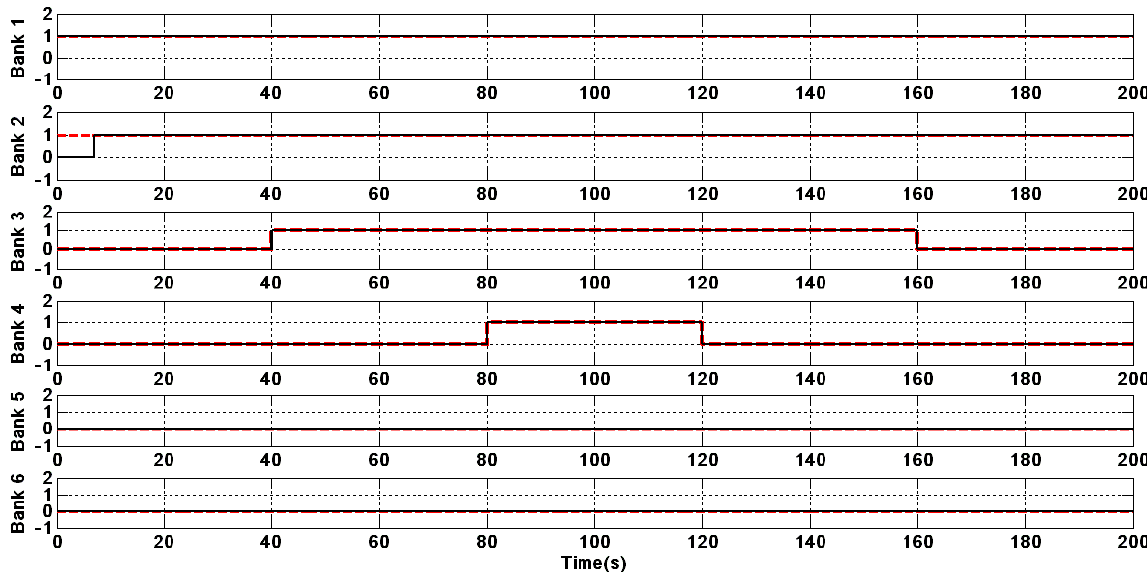
Figure 8. Automatic switching of the banks for the power reference of four banks (PI pitch angle